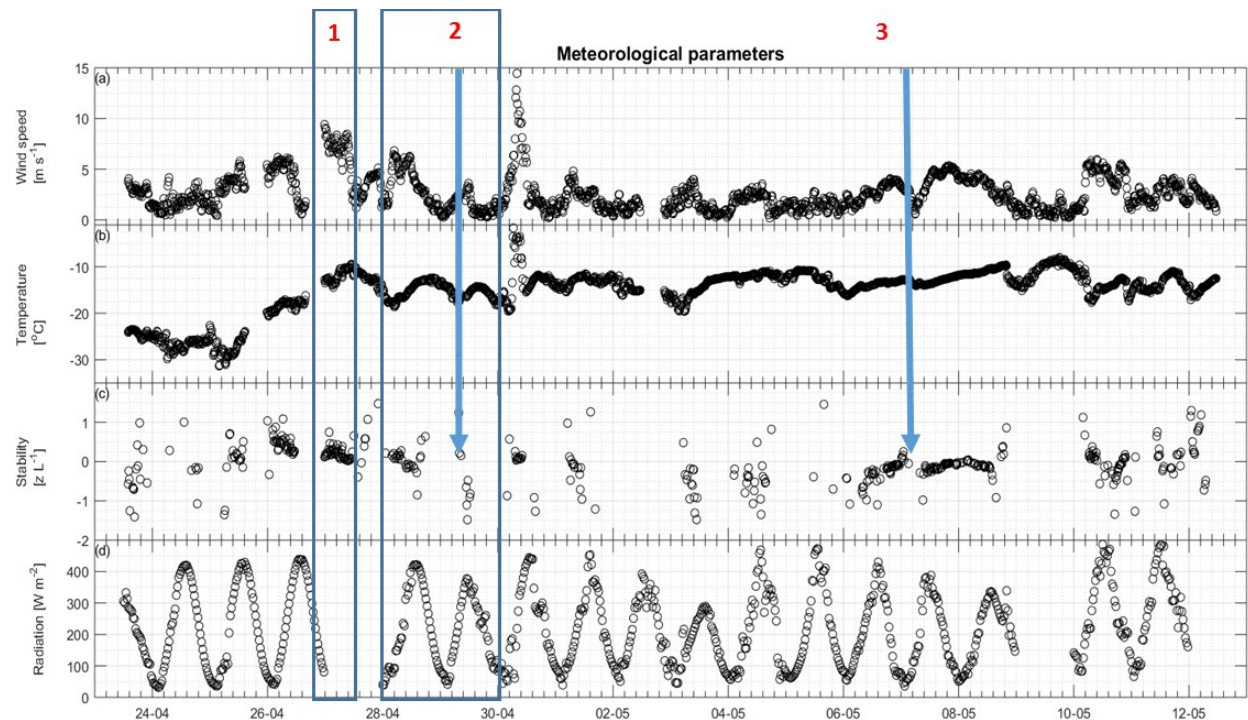
Figure 6. Meteorological parameters over time with three events highlighted. The arrows show the specific case of stability change referred to in the text. (a) Wind speed in ms − 1 , (b) temperature in ◦ C, (c) stability as zL − 1 and (d) radiation as Wm − 2